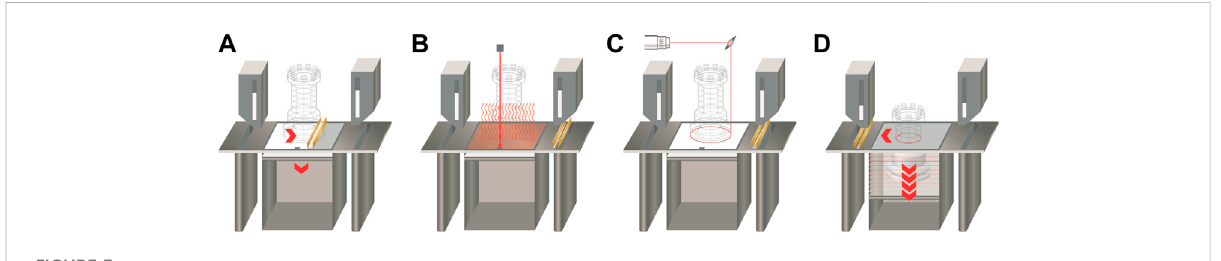
FIGURE 3 Process steps in PBF-LB/P: (A) dosing of feedstock from the hopper and subsequent powder deposition by a rake, (B) heating of newly applied powder layer by IR heaters (control via a pyrometer), (C) selective fusion of the powder according to the contour of the component by a laser, (D) lowering of building platform. The process steps (A) to (D) are repeated until the part is complete (adapted from